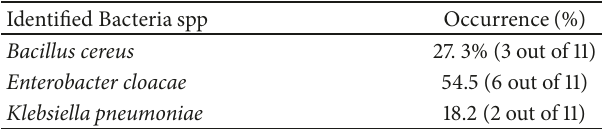
Table 2: Occurrence of bacteria isolates identified in feed